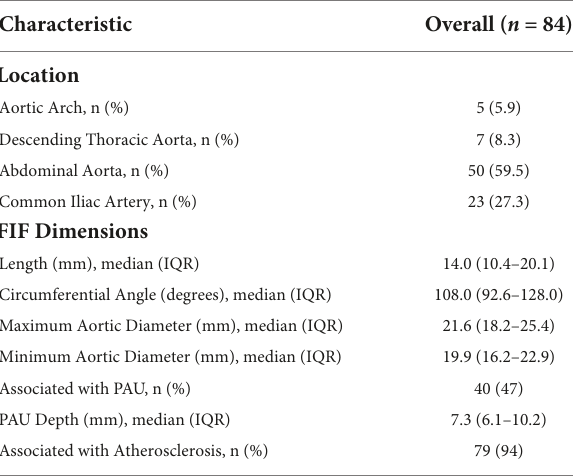
TABLE 2 Focal intimal flaps (FIF) imaging